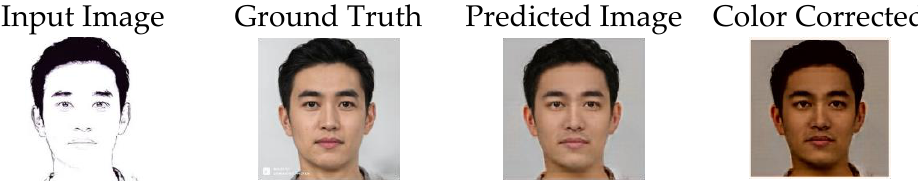
Figure 8. Results of tan configuration in correcting the color of predicted images. The ground truth images are from generated photos [17].